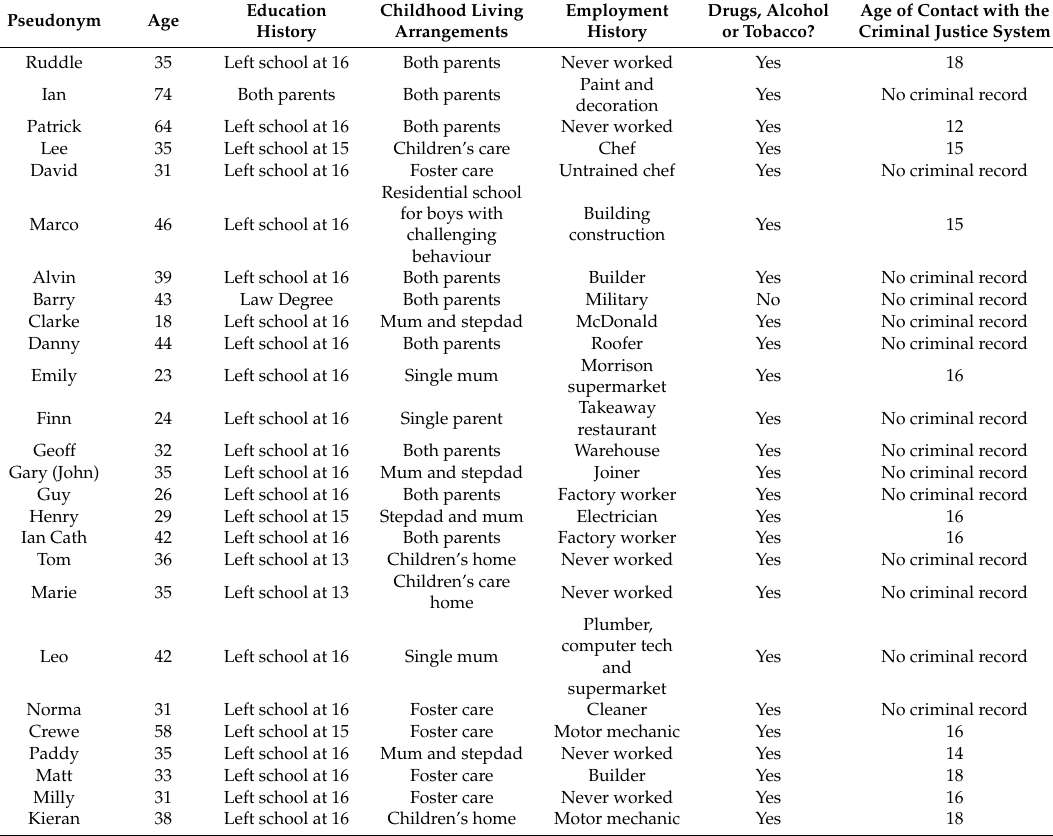
Table 1. Participants’ demographic